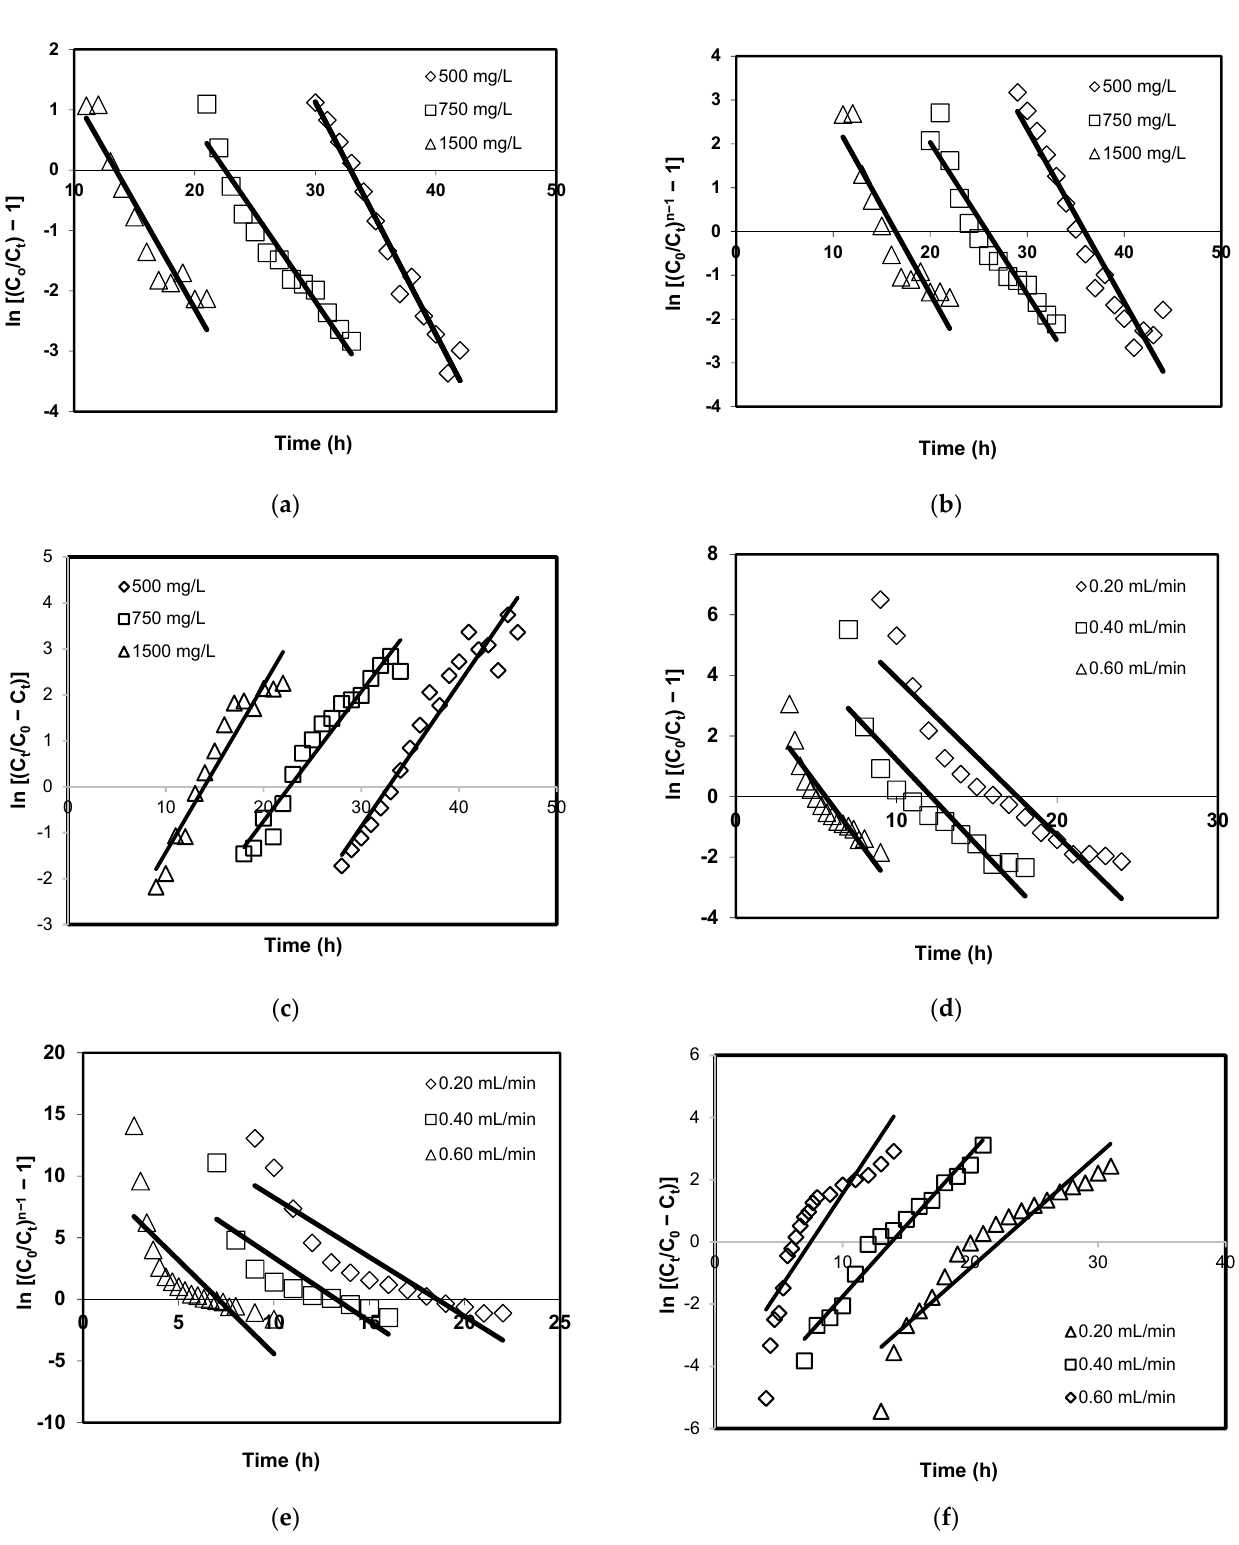
Figure 4. Adsorption of Pb(II) using CCB under a fixed-bed system under various initial concentra- tions fitted with the ( a ) Thomas model, ( b ) Clark model, and ( c ) Yoon–Nelson model. Effect of flow rate on the adsorption of Pb(II) using CCB under a fixed-bed system fitted with the ( d ) Thomas model, ( e ) Clark model, and ( f ) Yoon–Nelson